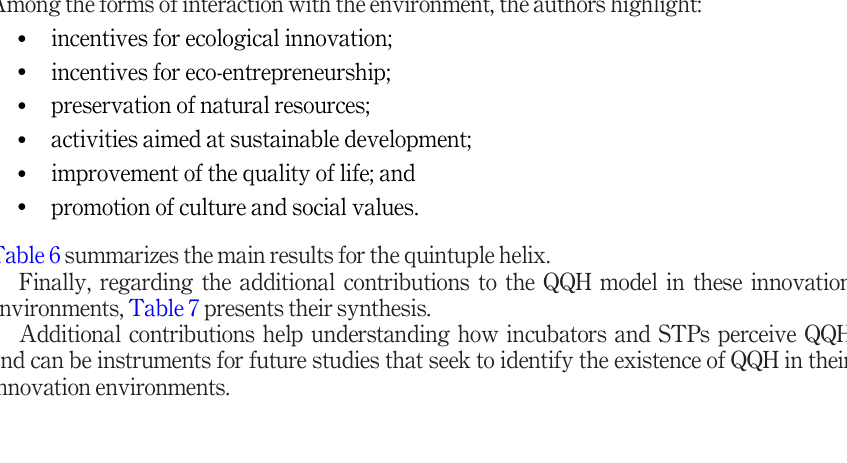
Authors Results from the quintuple helix Bikse et al.